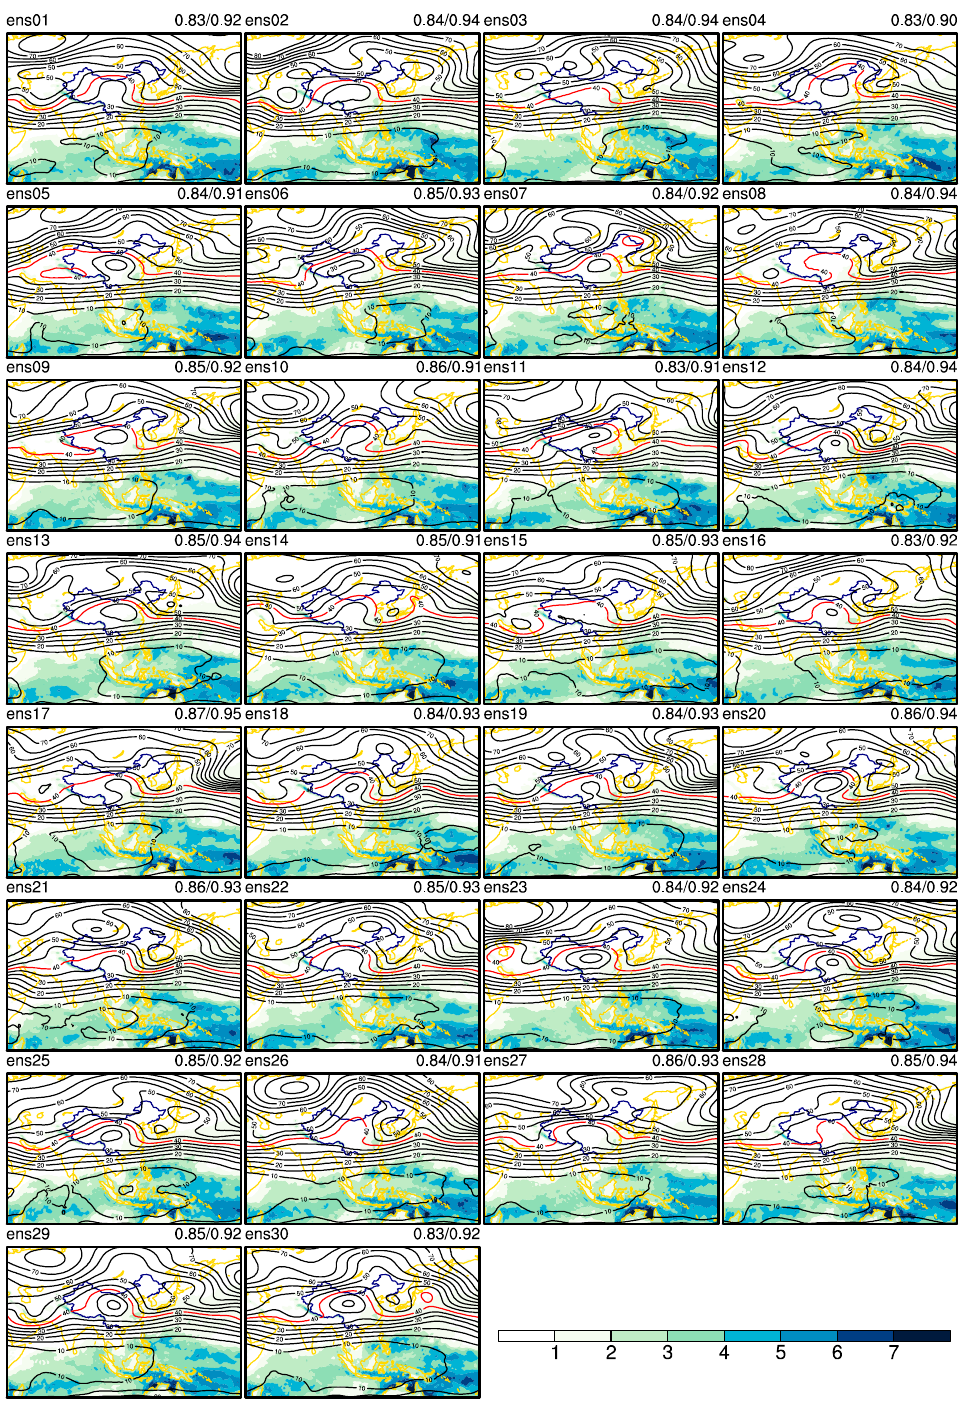
Figure 10. The intraseasonal variability (see text for details) of rainfall (shading; unit of mm/day) and Z200 (contours; int: 5 gpm; red ones for 40 gpm) during winter in each of the 30 ensemble members of ECHAM5. The numbers in top-right corner of each panel indicate pattern correlation with the pattern of spread (Figure 5a) for rainfall and Z200, respectively.